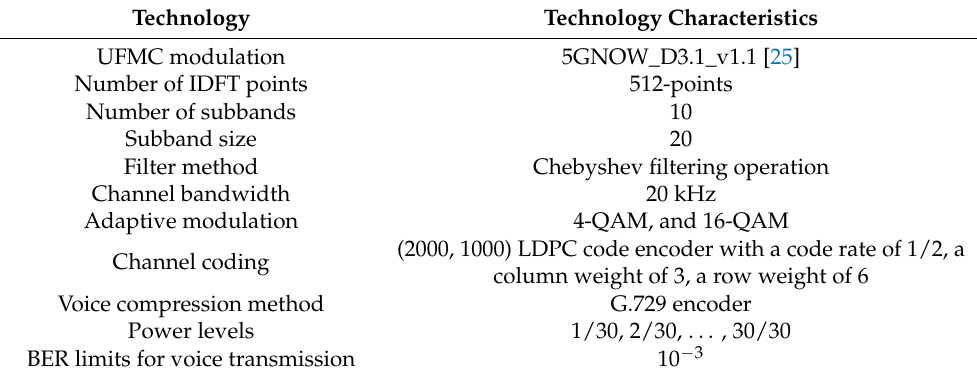
Figure 1. The proposed universal filtered multicarrier (UFMC)-based underwater transceiver with a low-density parity-check (LDPC) code for voice signals. Table 1. Simulation parameters of the proposed UFMC-based underwater transceiver with an LDPC